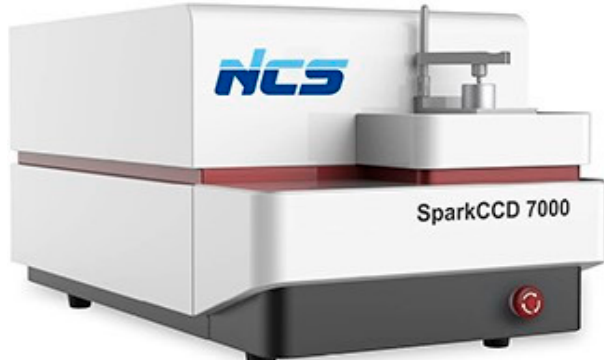
Figure 1. Direct-reading of the spectrometer.